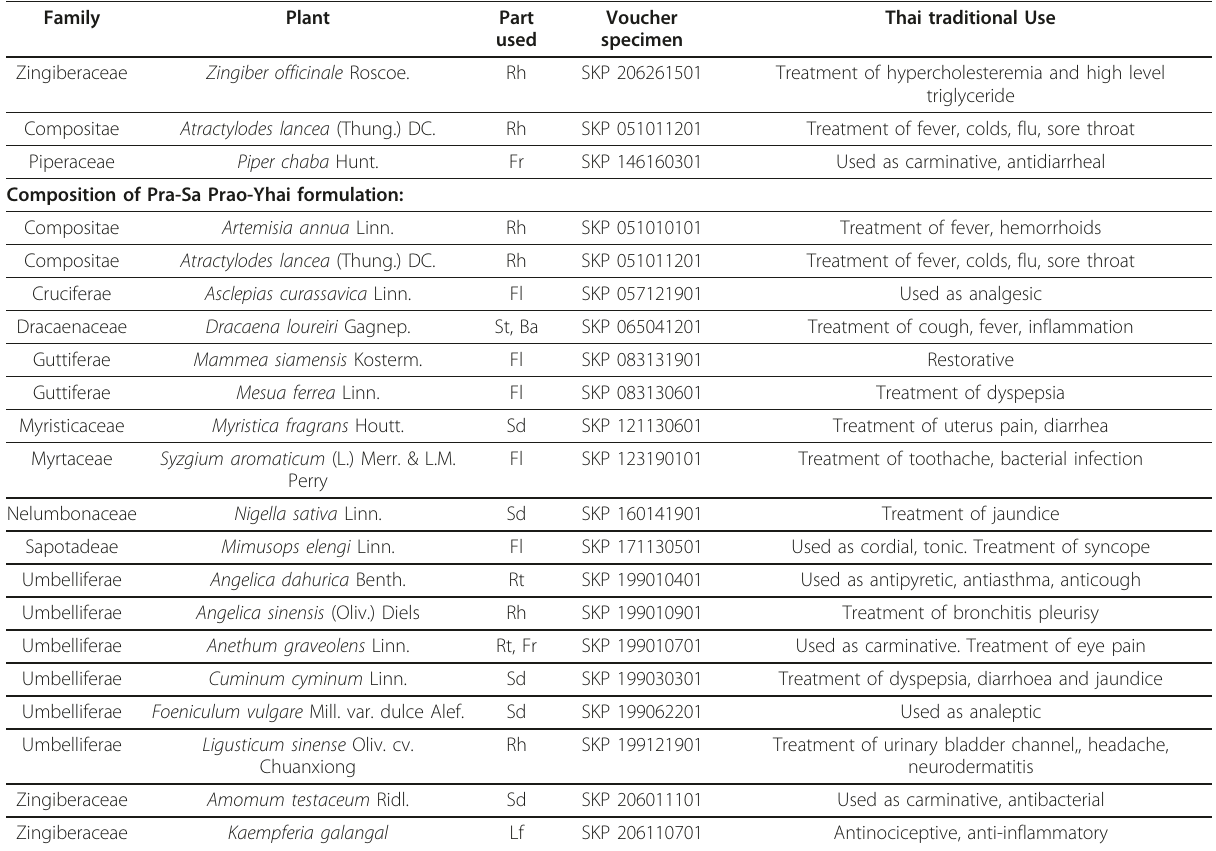
Table 1 Medicinal plants and herbal formulations under investigation